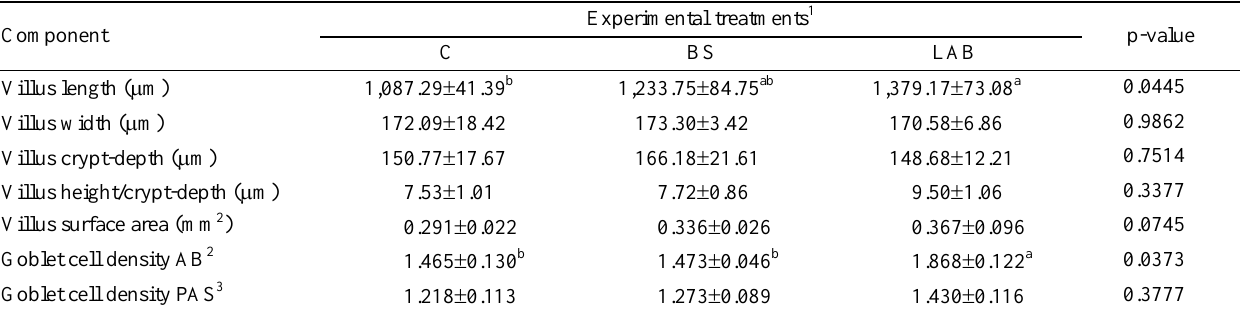
Table 3. Effect of probiotic supplementations on histomorphological parameters of intestinal jejunum section of broilers at 42 d of age Component